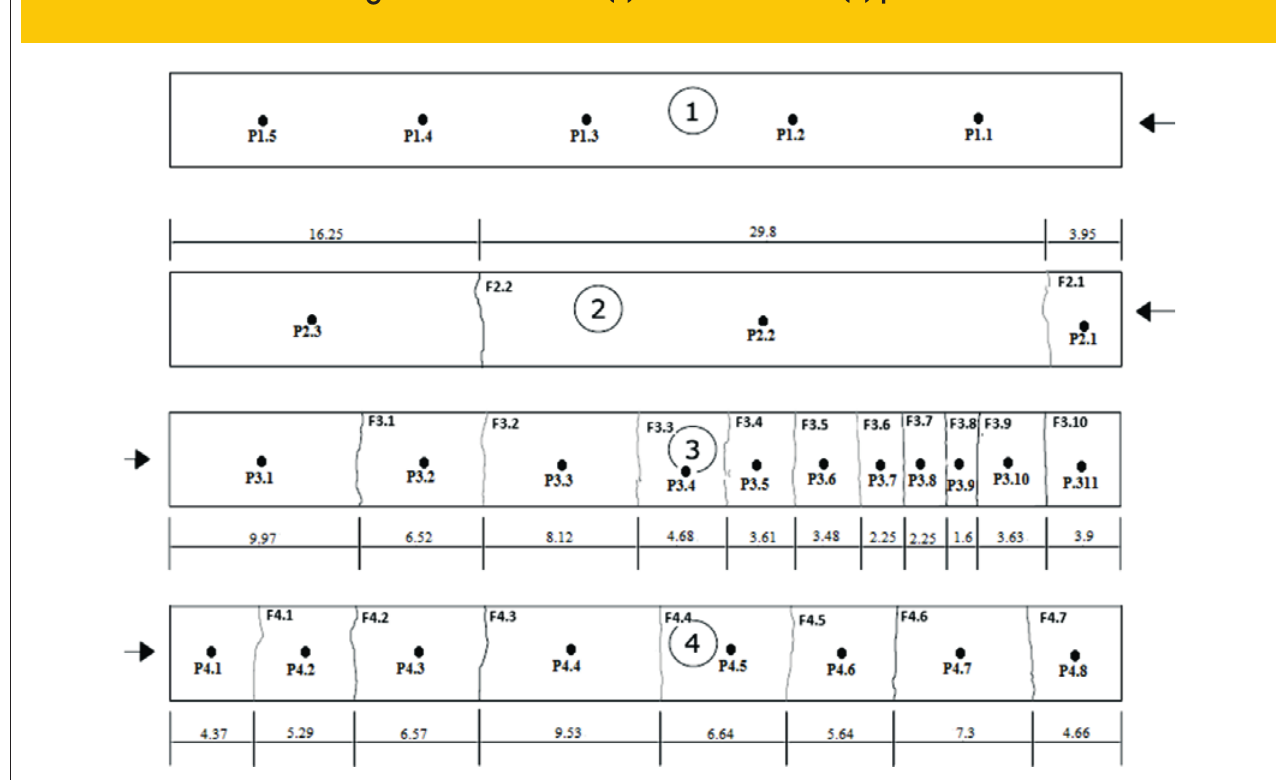
Figure 3 – FWD crack (F) and slab center (P)